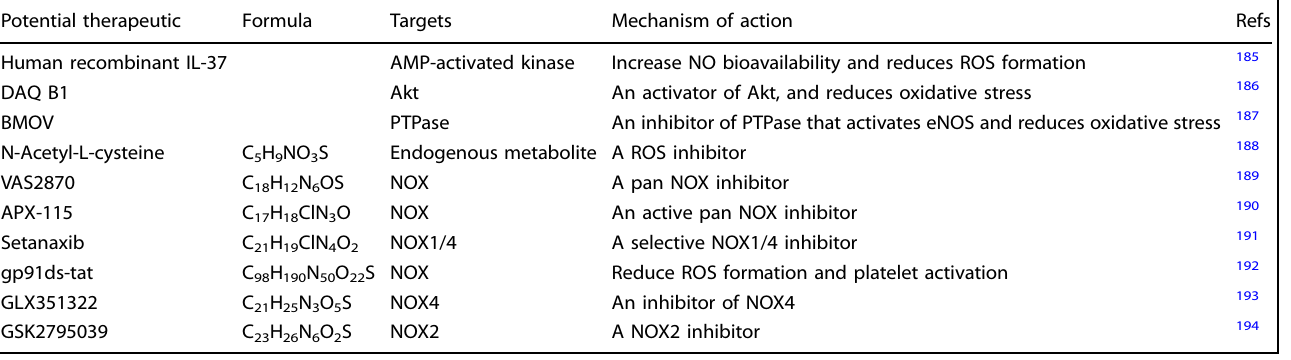
Table 6. Potential therapeutic tools for antioxidant treatment during COVID-19